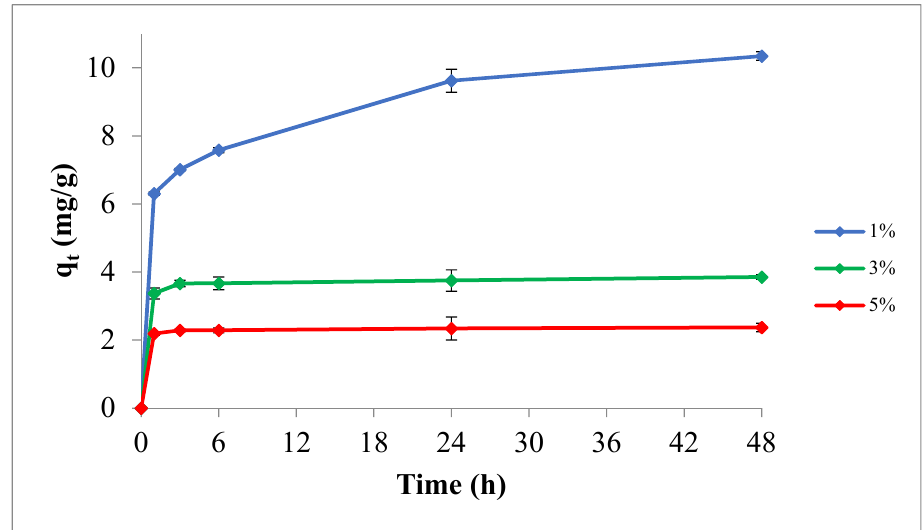
Figure 8. Influence of the adsorbent dose on the adsorption process at temperature of 295 K, pH 5.0, and initial TPC of 124 mg/L.